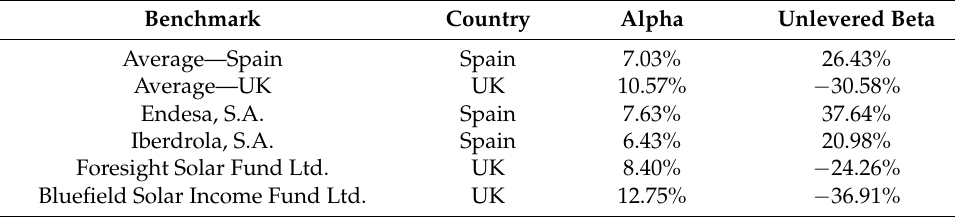
Table 8. Alpha and unlevered beta estimates. Benchmark Country